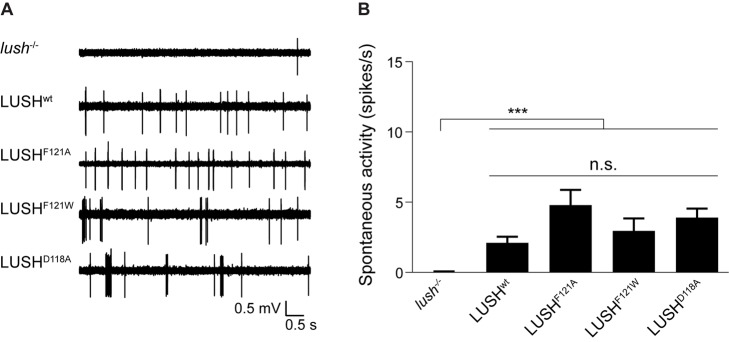
Mutation of LUSHD118 does not increase spontaneous activity in OR67d neurons.(A) Representative traces of spontaneous activity in OR67d neurons in lush
−/−, LUSHwt, LUSHF121A, LUSHF121W, and LUSHD118A flies. (B) Quantification of mean spontaneous activity in the genotypes in (A) (±SEM; n = 19–20 sensilla; ≤3 sensilla per animal). There are no statistically significant differences in spontaneous activity due to genotype between all the transgenic lines tested (Kruskal-Wallis, p = 0.0610). Only lush
−/− null mutants have a statistically significant decrease in spontaneous activity when compared to all the other genotypes (p<0.0001, Dunn's multiple comparison tests).